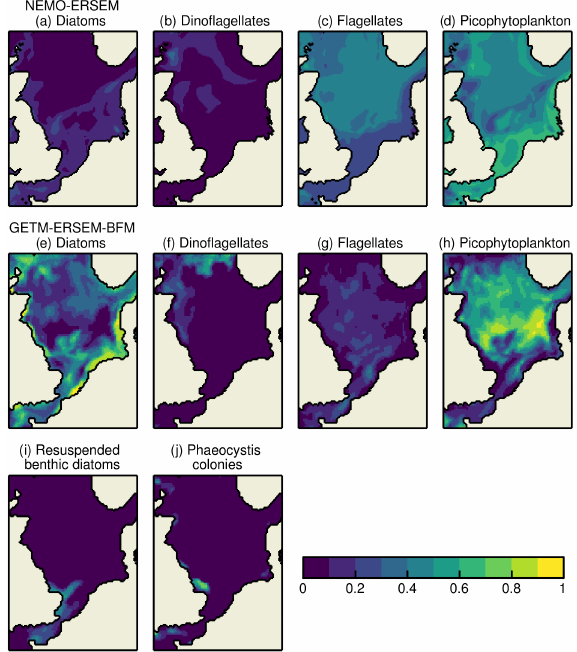
Figure 10. Maps of monthly mean sea surface PFT fractions for August 2010 from NEMO-ERSEM (a–d) and GETM-ERSEM- BFM (e–j) . PFT fractions have been calculated as the proportion of the total sea surface chlorophyll